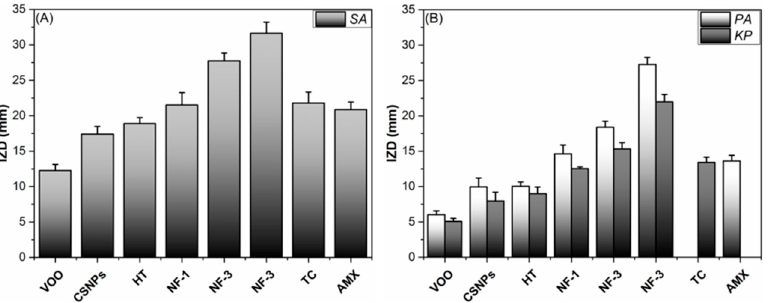
Figure 5. Graph for the inhibition zone diameter (IZD, mm) for the examined NFs against ( A ) Gram-positive bacteria and ( B ) Gram-negative bacteria. Table 3. MIC and MBC values ( μ g/mL) of new PBA-CSNPs-supported NFs against ESKAPE path- ogens, as compared to clinical antibiotics (GM and TC).